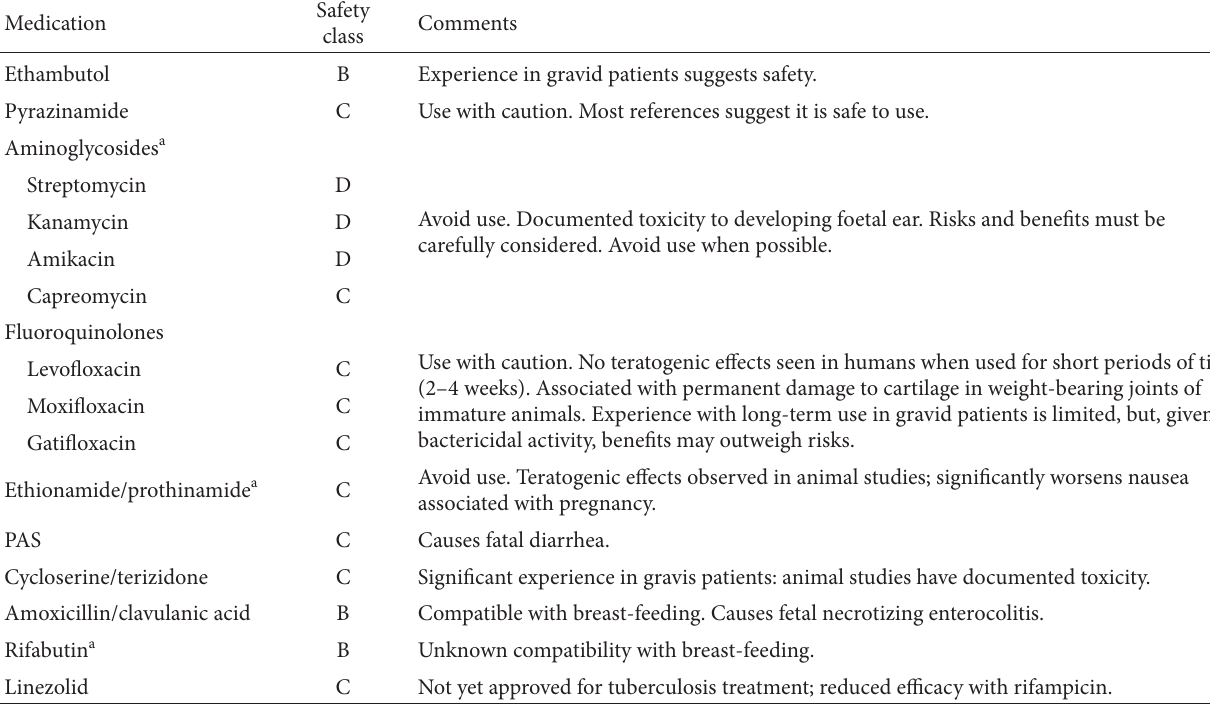
Table 1: Safety of MDR-TB medicines during